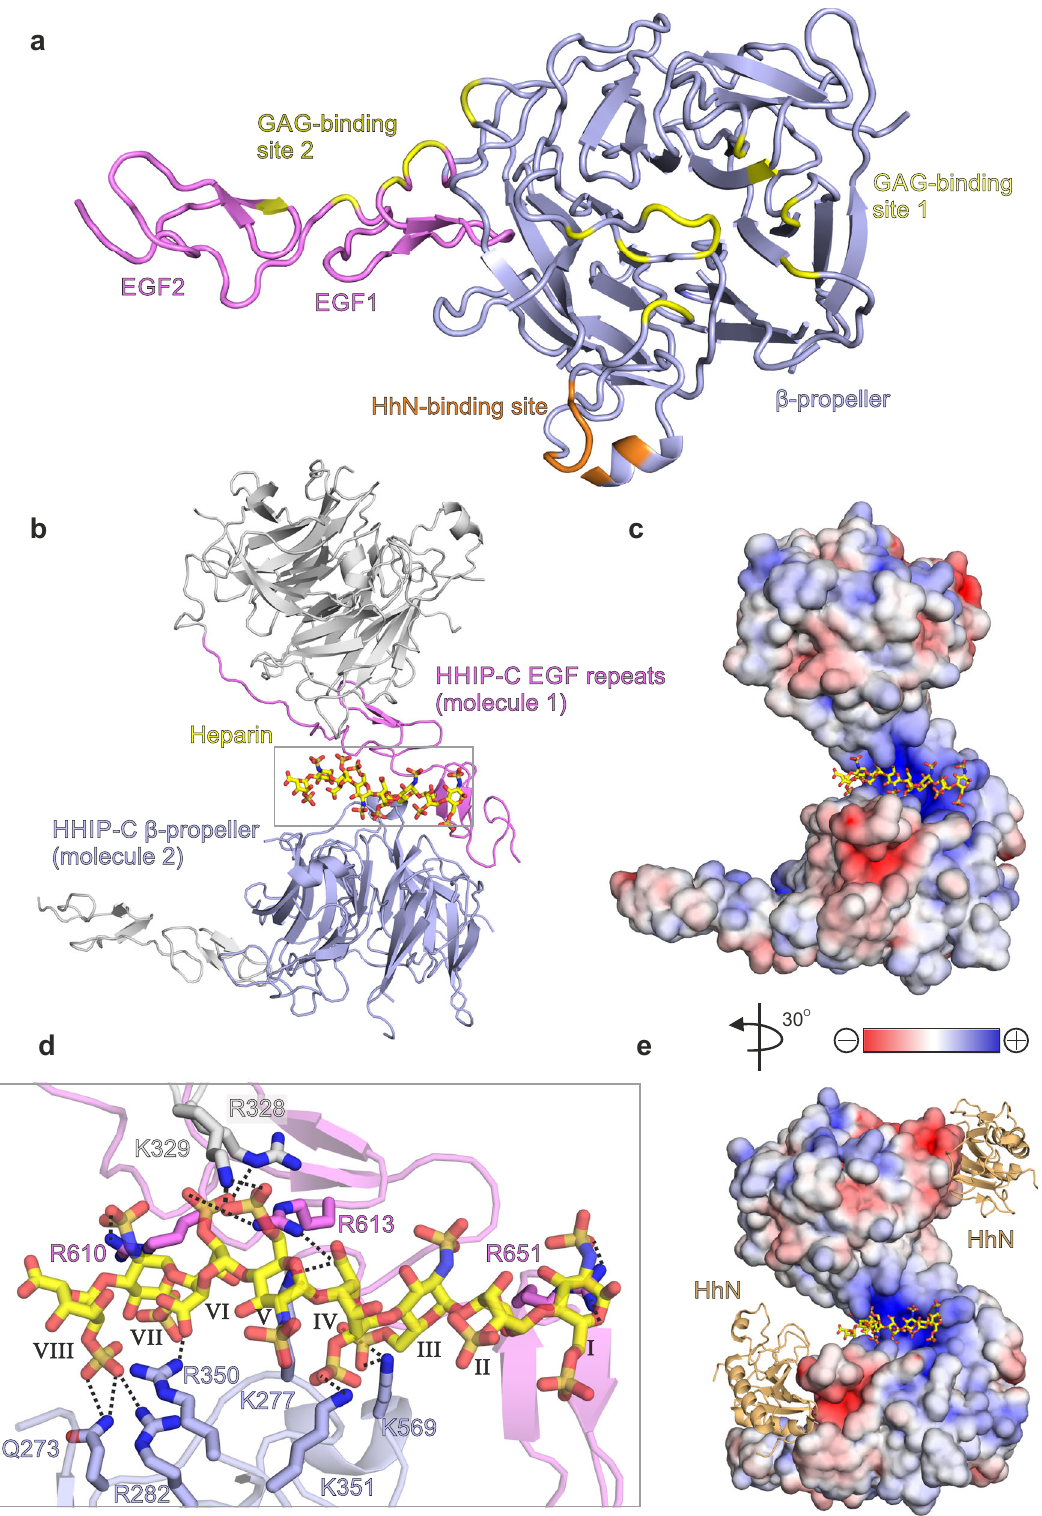
Fig. 4 The structure of the HHIP-C:heparin complex. a Cartoon representation of the HHIP-C monomer structure with the β -propeller domain in slate, the EGF repeats in magenta, the GAG-binding sites in yellow and the HhN-binding site in orange. b Arrangement of the two HHIP-C molecules (cartoon representation) around a centrally-coordinated heparin molecule (stick representation). c Close-up view of the boxed region in B, displaying side chain:heparin interactions. Hydrogen bonds are displayed as black dashed lines and sugar residues are numbered using roman numerals (odd, N,O6- disulphoglucosamine; even, O2-Sulphoiduronic acid). d Electrostatic surface potential shown from red ( − 8 kT/e) to blue ( + 8 kT/e) with heparin chain shown as sticks. e Comparison of heparin (yellow sticks) and HhN (orange cartoon) interaction sites on HHIP-C electrostatic